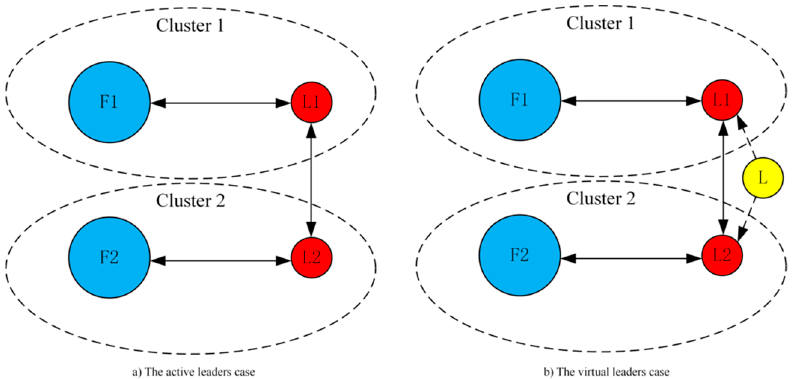
Figure 1. Example for the step-by-step consensus algorithm, L1 and L2 are active leaders, L is a virtual leader.